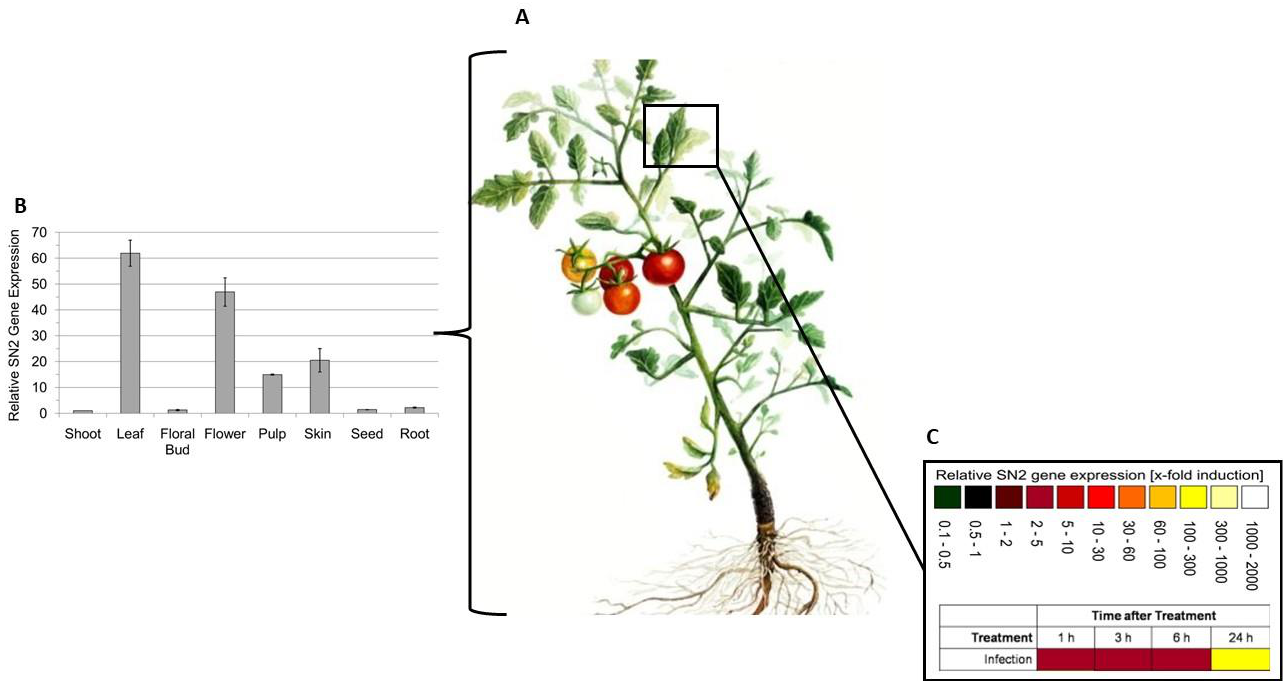
Figure 1. Relative gene expression of Snakin-2 in Solanum lycopersicum plants. ( A ) Diagram of a Solanum lycopersicum plant (Tomato) at the fruit-bearing stage. ( B ) Relative gene expression levels of SN2, using qRT-PCR, in healthy adult S. lycopersicum plant. SN2 recorded the highest expression in the leaves and flowers, respectively; therefore, further analysis of SN2 activity was conducted on the leaves [70]. ( C ) Relative gene expression levels of SN2, using qRT-PCR, after infection of tomato plant with pathogenic F. solani. The heatmap represents an upregulation of SN2 expression over 24 h, with the expression of SN2 being highest at the 24 h. This illustrates that the presence of F. solani in the tomato plants strongly increases the expression of the SN2 gene as a defense against